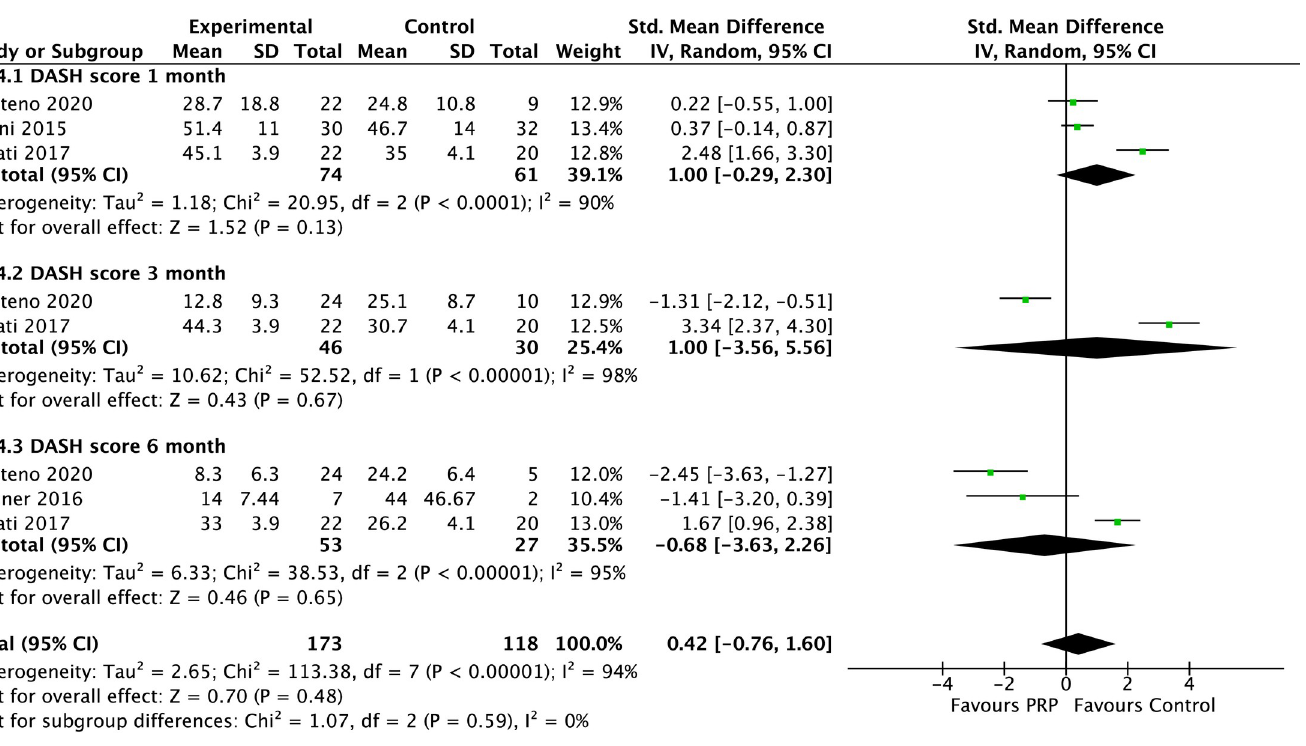
Fig 6. Forest plot on DASH functional shoulder scores based on follow-up periods.